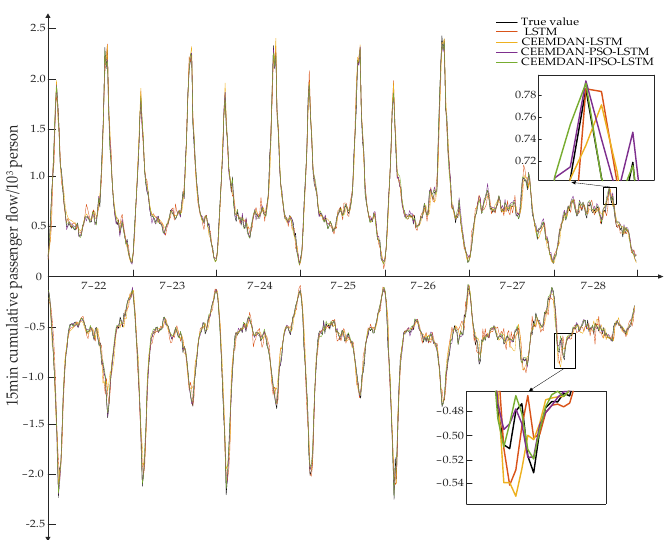
Figure 7. Prediction results of inbound and outbound passenger flow of different models in the last week.